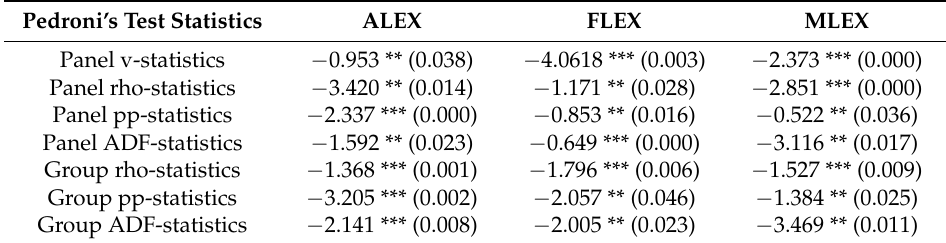
Table 3. Results of the panel cointegration test for aggregate life expectancy (ALEX), female life expectancy (FLEX) and male life expectancy